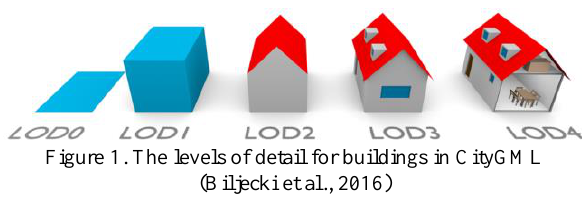
Figure 1. The levels of detail for buildings in CityGML (Biljecki et al.,